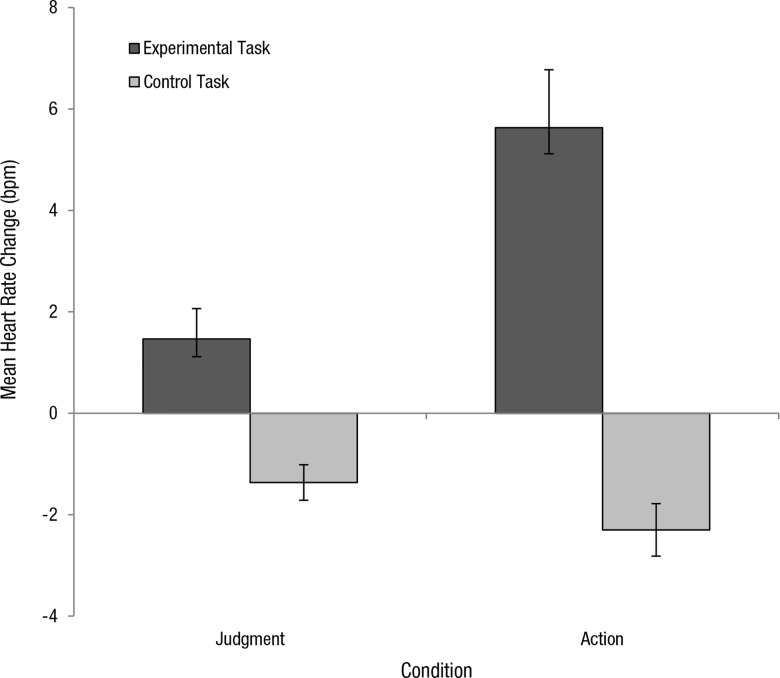
Mean heart rate change (bpm) for control and experimental tasks in both the judgment and action conditions.Heart rate change was significantly higher in the virtual moral dilemma. Error bars represent +- 1 SE